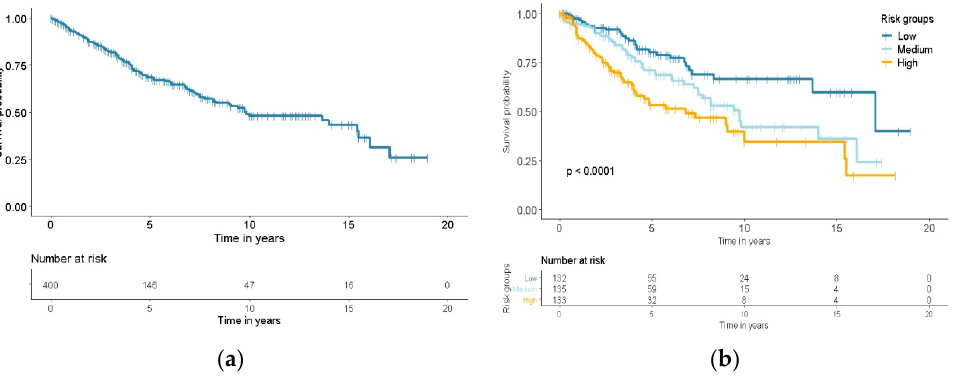
Figure 1. Kaplan–Meier curves for disease specific survival: ( a ) Disease specific survival curve of the institutional cohort; ( b ) Disease specific survival curves for low-, medium- and high-risk strata. Logrank test was performed for comparisons between survival.